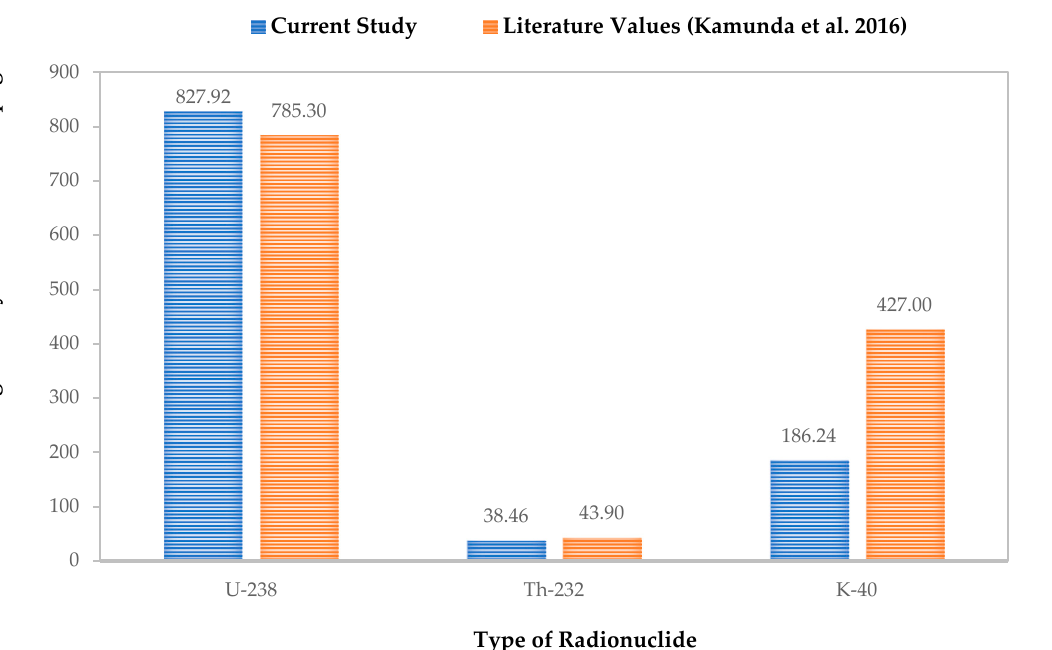
Figure 4. A comparison of the collective average activity concentrations obtained in the current study with those found in mine tailings in the Wonderfonteinspruit Catchment Area [9] . Table 1. In situ activity concentration of 238 U, 232 Th, and 40 K in the gold mine tailings of the West Rand area and the corresponding absorbed dose and effective dose.